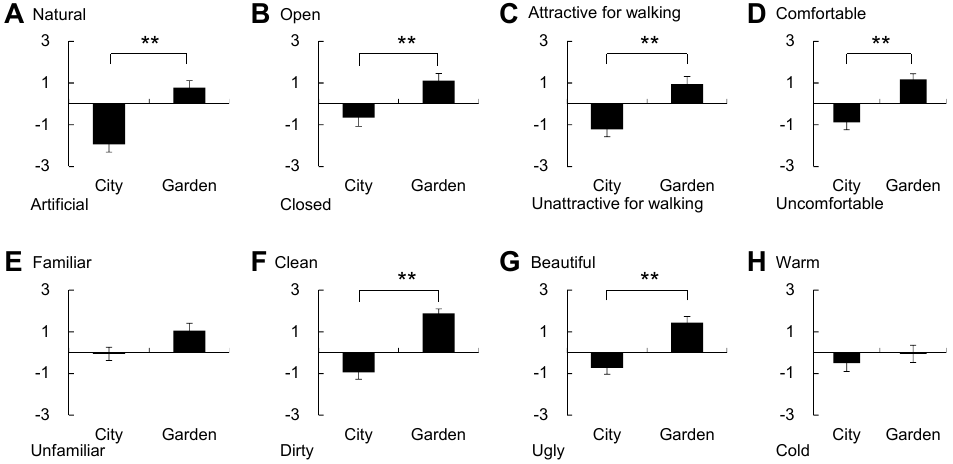
Figure 6. Comparison of the semantic differential (SD) scores for eight different feelings between city and garden landscapes. Subfigures indicate the feelings of natural-artificial ( A ), open-closed ( B ), attractive for walking-unattractive for walking ( C ), comfortable–uncomfortable ( D ), familiar-unfamiliar ( E ), clean-dirty ( F ), beautiful-ugly ( G ) and warm-cold ( H ). Mean ± standard error; N = 18; ** p < 0.01. When comparing the POMS scores between male and female participants, a significant difference was found in the T-A subscale. The male group, but not the female, exhibited a significant difference